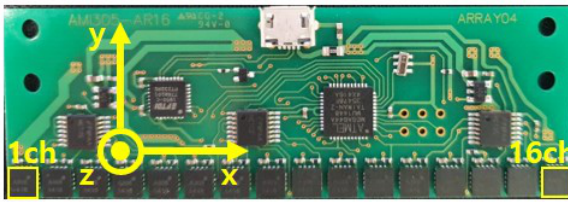
Figure 4. 16ch MI